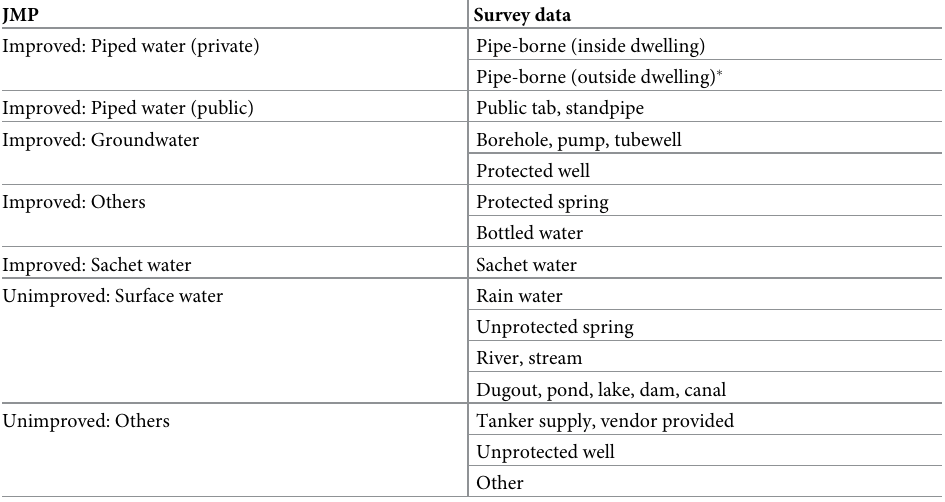
Table 1. Correspondence between the JMP classification system and that used by the three surveys included in the present